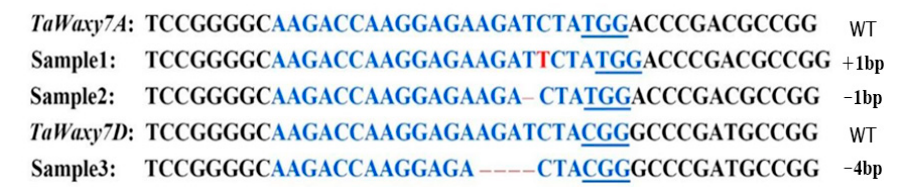
Figure 3. InDel mutations of the TaWaxy gene in the candidate mutants generated from the mature embryos after nicotinamide treatment. The PAM region is underlined; blue letters indicate sgRNA sequences; red letters indicate insertions; dashed lines represent nucleotide deletions.